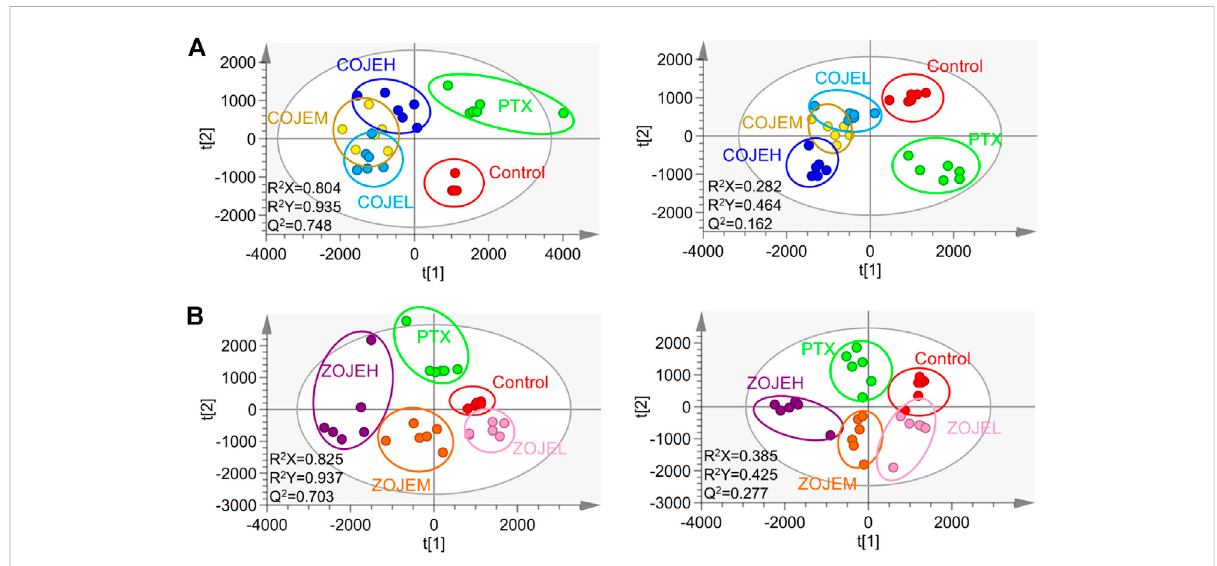
FIGURE 4 PLS-DA score plot based on the UHPLC/Q-TOF-MS spectra of NCI-H1299 cell samples in control, PTX and different concentration of (A) COJE- or (B) ZOJE-treated groups detected in positive ion mode (left) and negative ion mode (right).